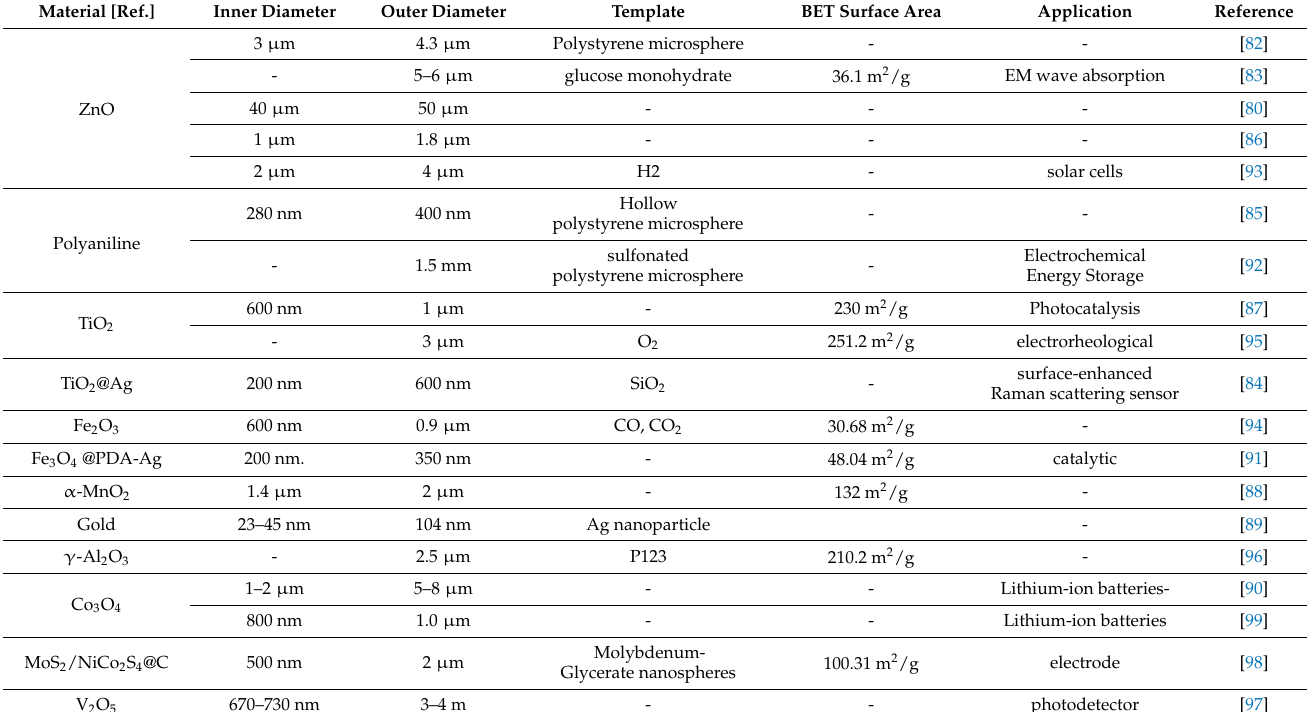
Table 2. The properties of urchin-like composite micro-/nanoparticles. Material